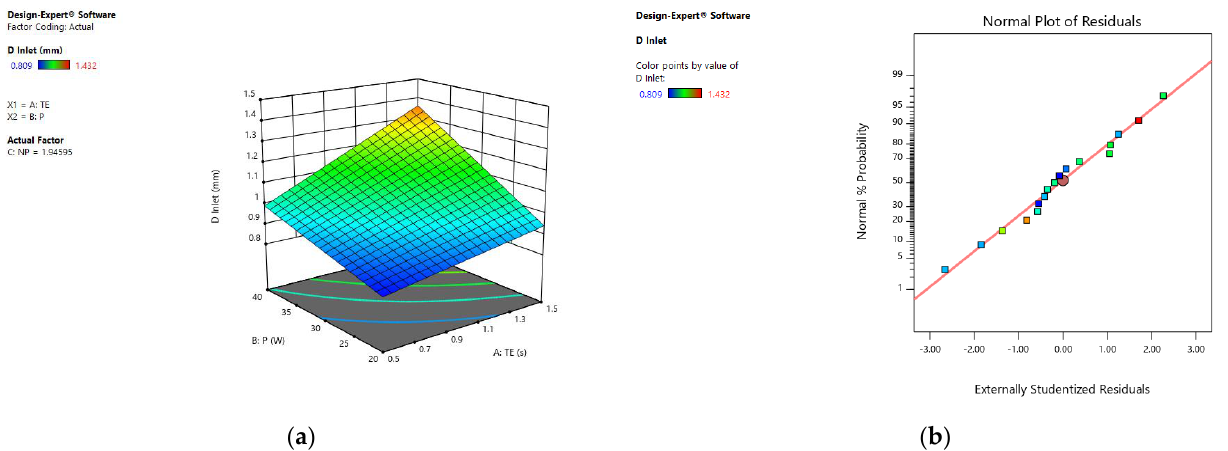
Figure 15. ANOVA model results for D INLET at 0.075 wt.% CNPs: ( a ) 3D response surface and ( b ) normal residuals